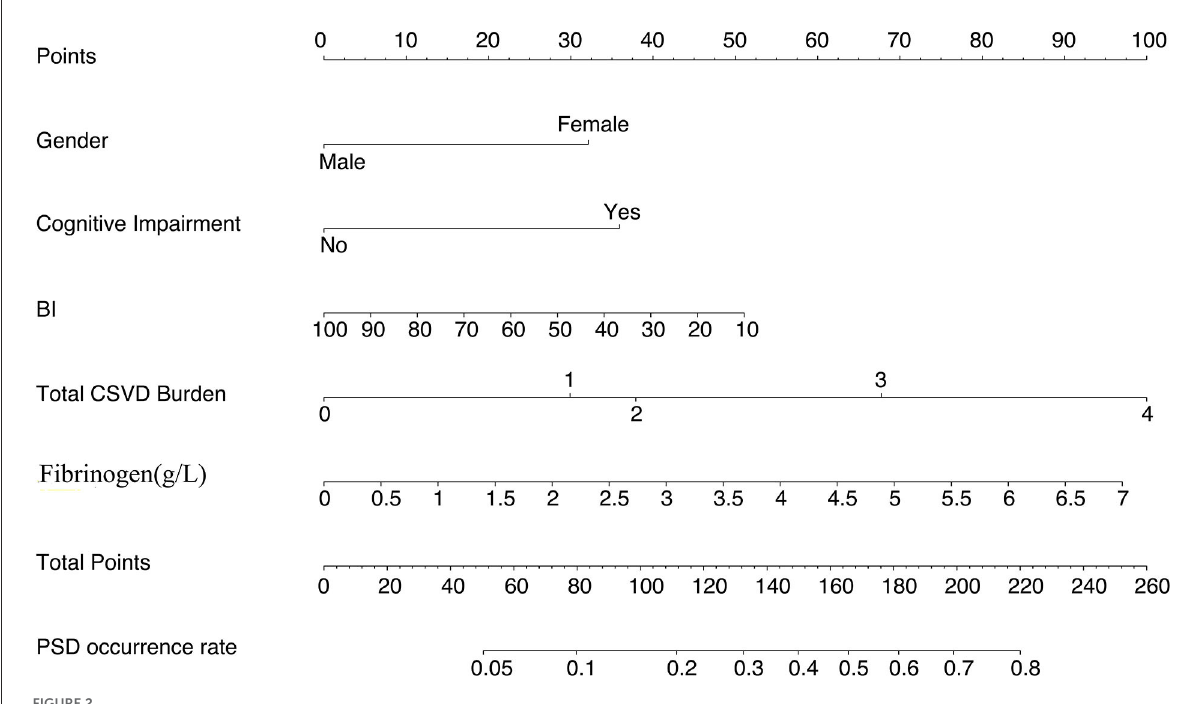
FIGURE2 Nomogram predicting early-onset PSD. BI, Barthel